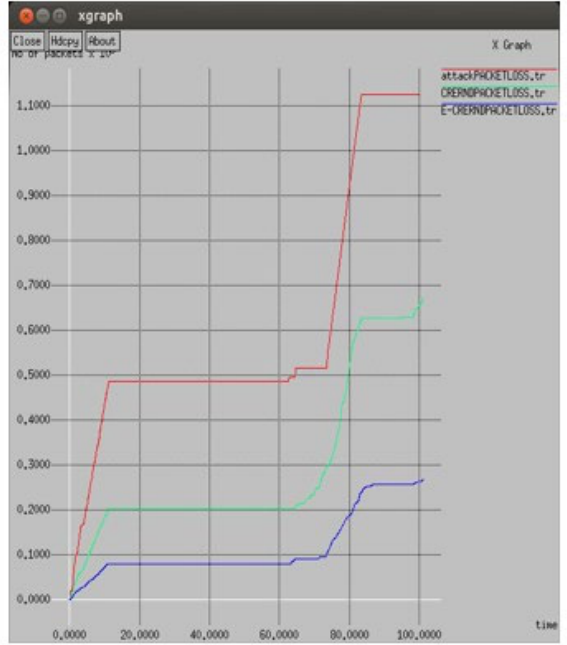
Figure 7: Proposed